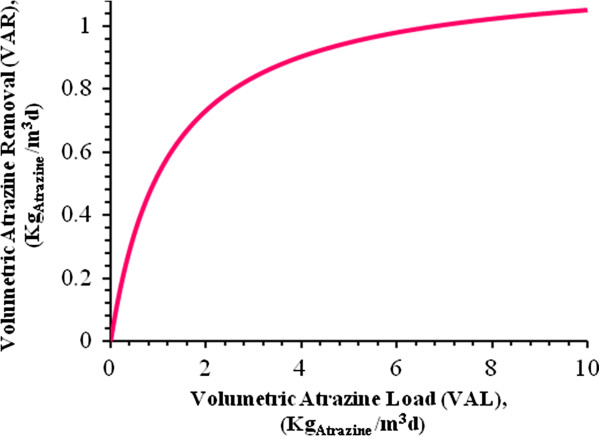
Atrazine loading of the bioreactor in the range of 0 to 10KgAtrazine/m3d at 32°C.